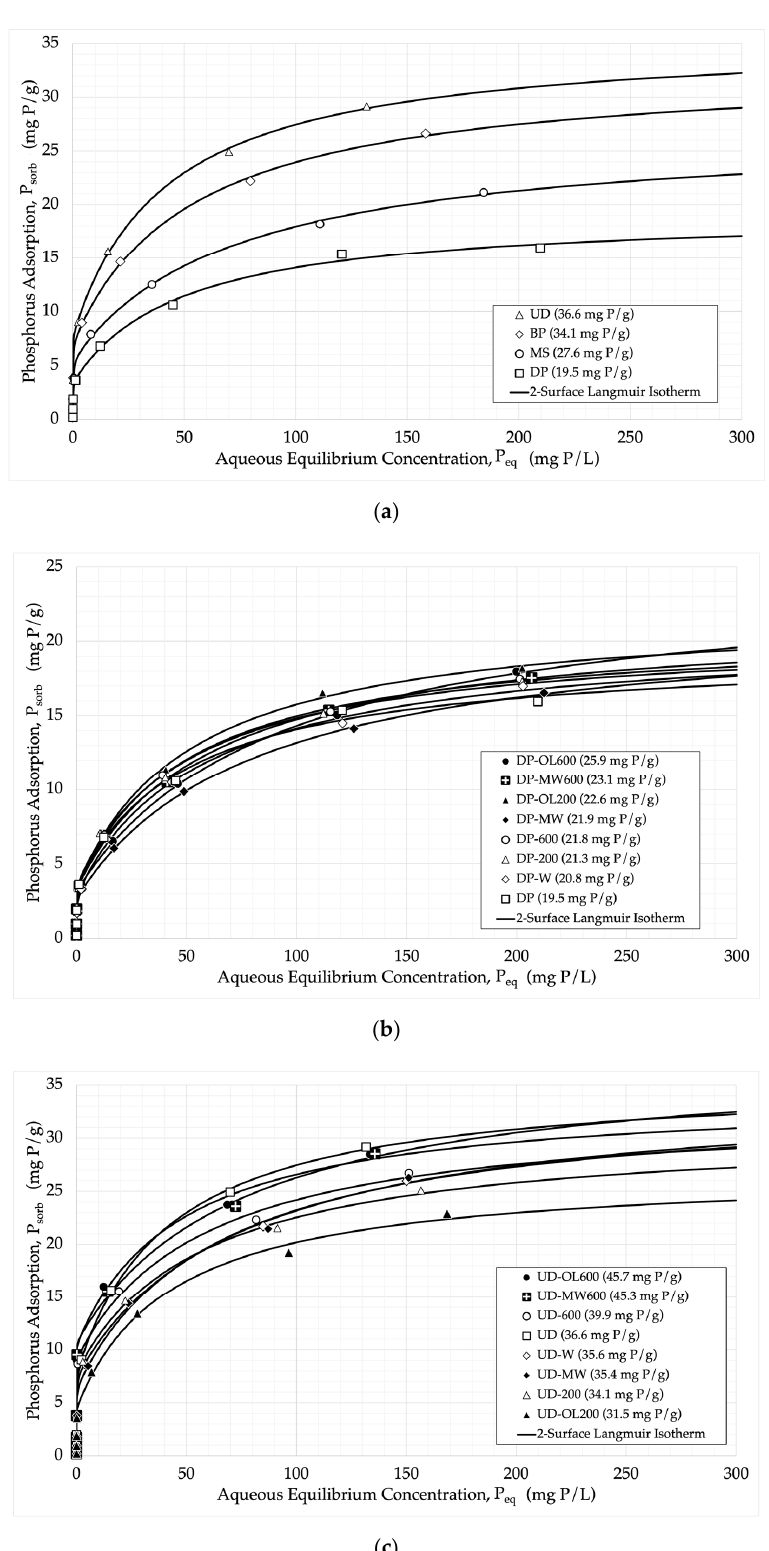
Figure 4. P sorption batch experimental data fitted with two-surface Langmuir isotherms for: ( a ) four air-dried DWTRs without treatment; ( b ) one air-dried and seven experimentally treated DWTRs from DP WTP; ( c ) one air-dried and seven experimentally treated DWTRs from UD WTP. The values in parentheses represent the total P sorption capacity ( b